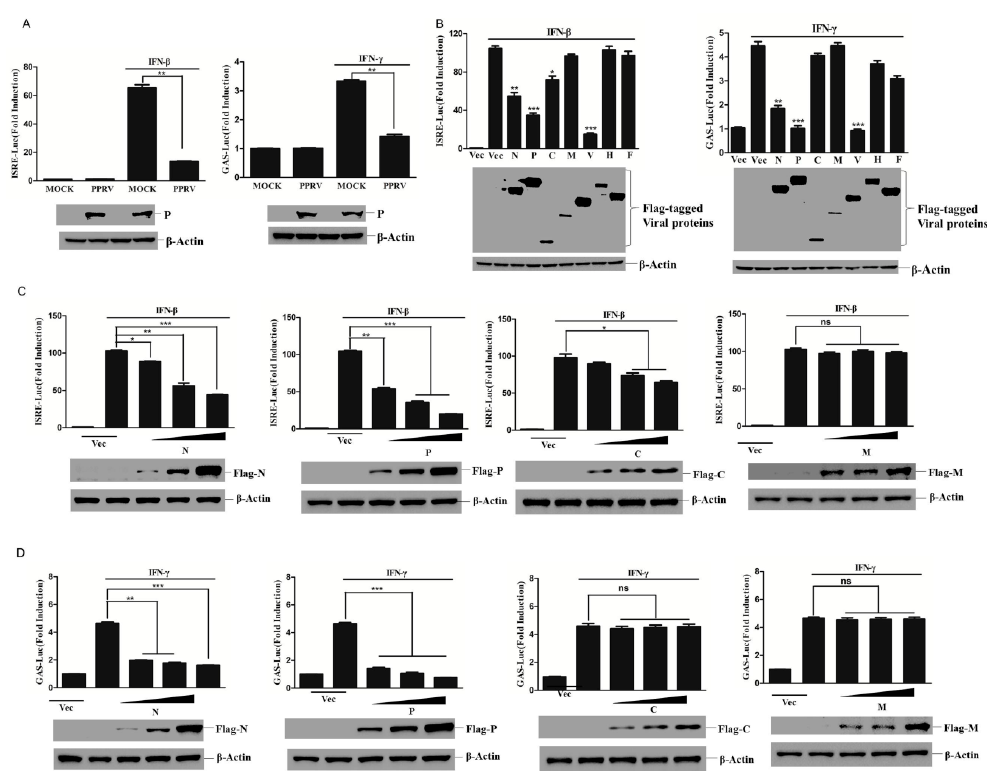
Figure 1. PPRV N and P proteins suppressed IFN- β and IFN- γ induced response. ( A ) HEK-293T cells in 24 well culture plates were transfected with ISRE (100 ng) or GAS (100 ng) reporter plasmids along with pRL-TK (10 ng) plasmid and mock-infected or infected by PPRV (0.1 MOI) at 6 h post-transfection (hpt) for another 48 h. The infected cells were then treated with IFN- β (1000 U/mL) or IFN- γ (100 ng/mL). Luciferase activity was measured at 12 h after IFN- β or IFN- γ treatment. The expression of viral P protein was detected by Western blotting and used as an infection indicator. ( B ) HEK-293T cells in 24 well culture plates were transfected with ISRE (100 ng) or GAS (100 ng) reporter plasmids together with pRL-TK (10 ng) plasmids and 200 ng of various PPRV viral protein expressing plasmids or vector plasmids. At 24 h post-transfection, the cells were treated or mock treated with IFN- β (1000 U/mL) or IFN- γ (100 ng/mL). Luciferase activity was determined at 12 h after IFN- β or